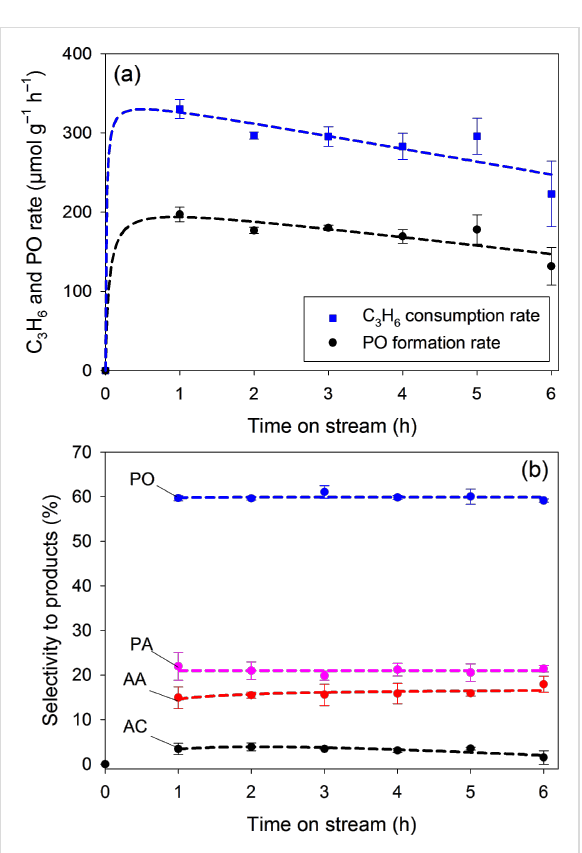
Figure 5: Time course of the photo-epoxidation of propylene with molecular oxygen under UV–visible light irradiation (without an AM1.5G filter; 18.5 mW·cm − 2 ): (a) C 3 H 6 consumption rate and PO for- mation rate, (b) Selectivity to products. Lines are presented for guiding and are not based on a kinetic